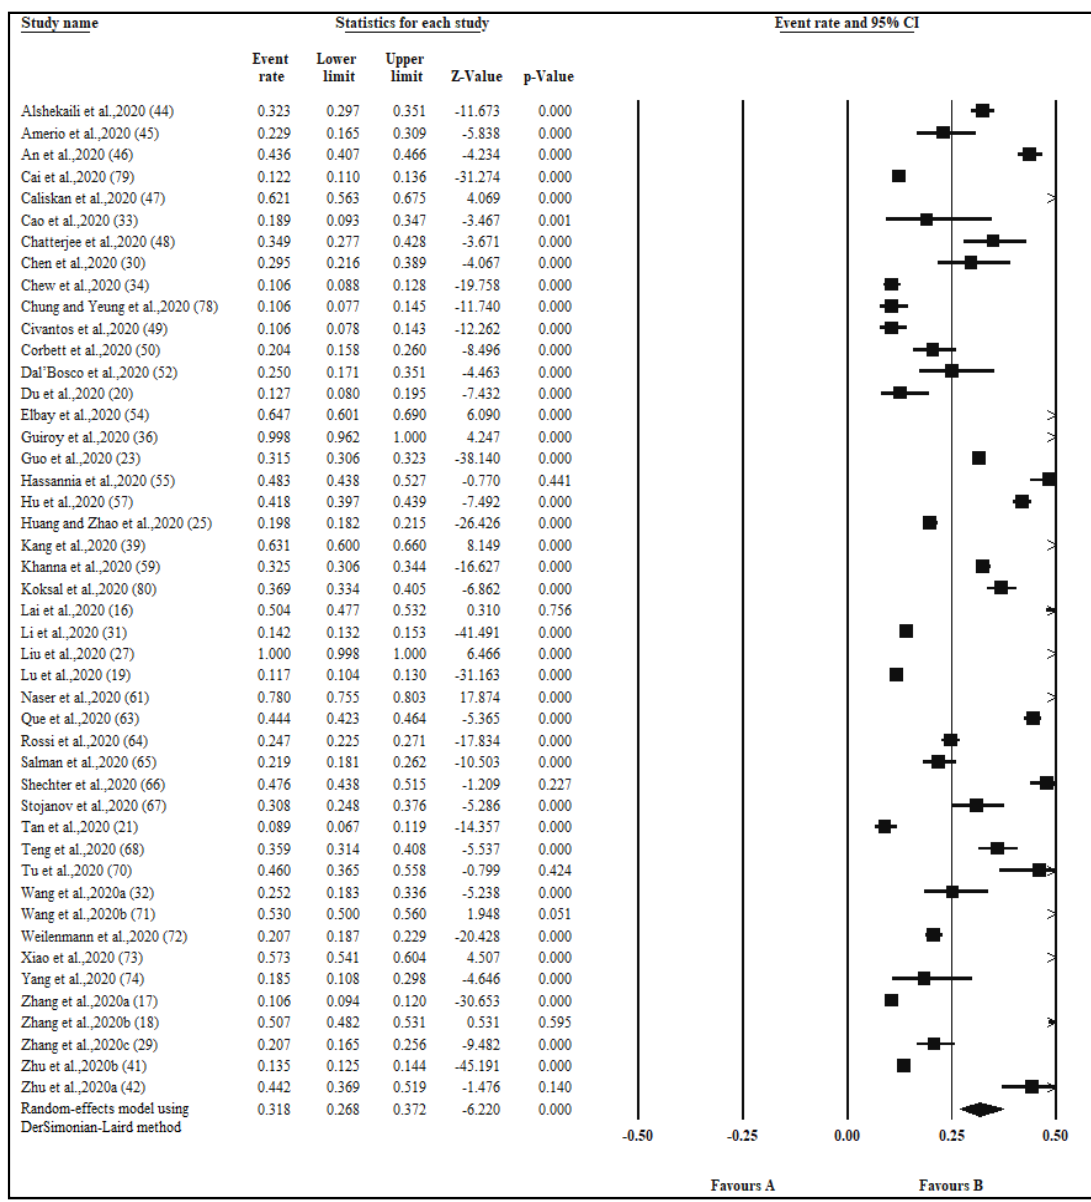
Figure 3. Forest plot for the studies on the prevalence of depression among healthcare workers. The squares and horizontal lines correspond to the study-specific event (anxiety) rates and 95% confidence intervals (CIs). The diamond represents the pooled prevalence and 95% CI of the overall population. The overall pooled depression using a random effects DerSimonian-Laird method was 31.8% (95% CI: 26.8–37.2).